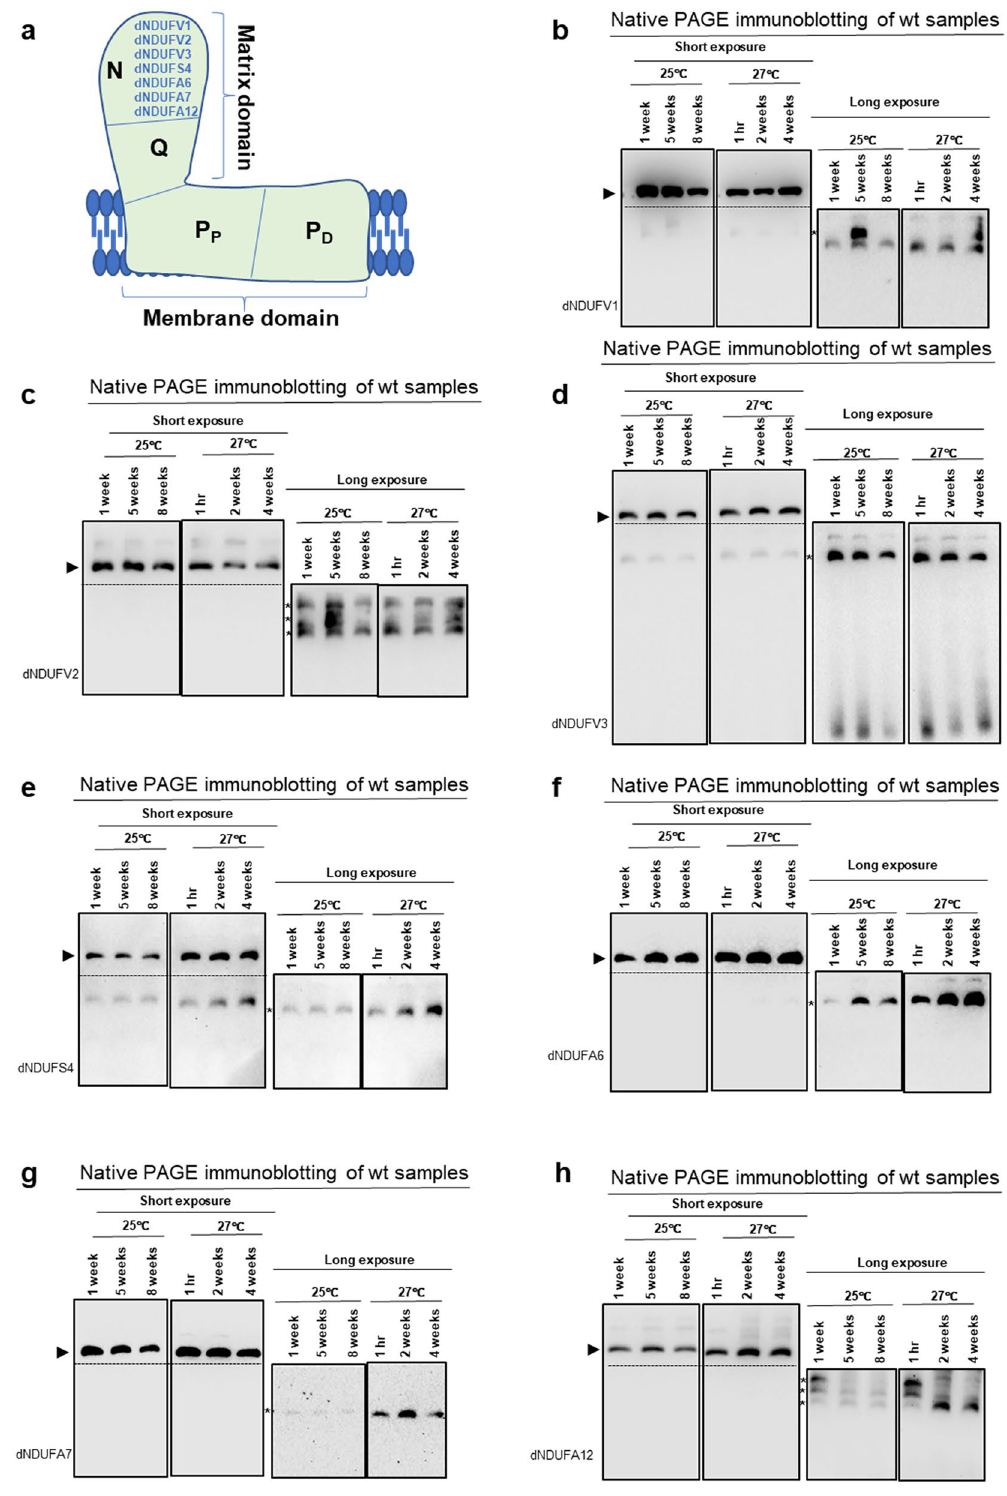
Figure 2. Stochastic expression of N-module subunits in subcomplexes with age. ( a ) An illustration of mitochondrial CI depicting the approximate positions of the N-, Q-, P P - and P D -modules. Biogenesis of the N-module was tracked by immunoblotting with antibodies against dNDUFV1, dNDUFV2, dNDUFV3, dNDUFS4, dNDUFA6, dNDUFA7 and dNDUFA12. ( b – h ) Mitochondrial preparations isolated from thoraces of wt flies at the time points shown and raised at the temperatures indicated were analyzed by BN-PAGE, followed by Western blotting with the antibodies indicated. The antibodies used were anti-dNDUFV1 ( b ), anti-dNDUFV2 ( c ), anti-dNDUFV3 ( d ), anti-dNDUFS4 ( e ), anti-dNDUFA6 ( f ), anti-dNDUFA7 ( g ), and anti-dNDUFA12 ( h ). The arrowheads mark the positions of the holoenzyme which was used as a loading control for the subcomplexes. The asterisks denote subcomplexes discussed in the text. See Fig. S4 for replicates and S7 for full-length gels and